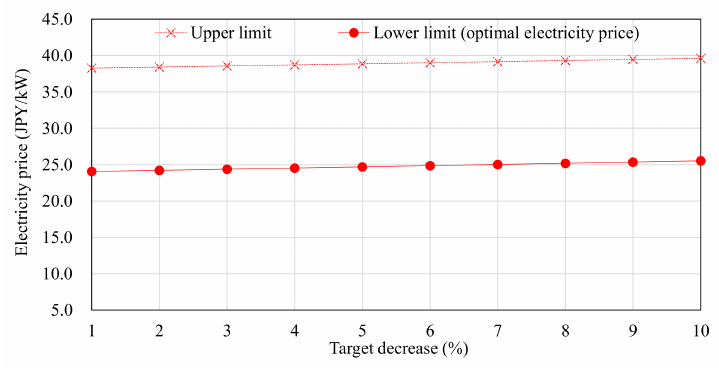
Figure 9. Results on the typical time slots in scenario 1 (at